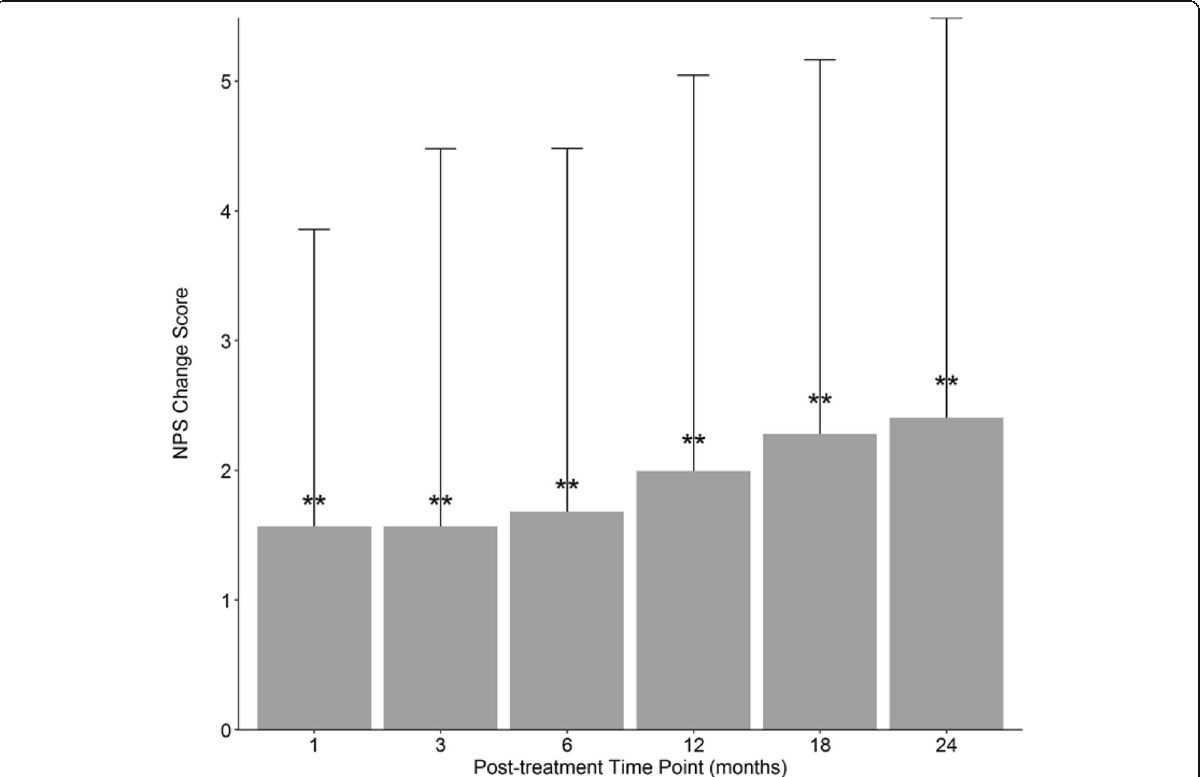
Fig. 3 NPS average change scores. Numeric pain score (NPS) average change from baseline to post-treatment with standard deviation. Number of patients reporting at each time point: 1-month ( N = 139); 3-month ( N = 192); 6-month ( N = 181); 12-month ( N = 174); 18-month ( N = 143); 24-month ( N = 126). Statistical comparisons are to baseline. ** p < .0001